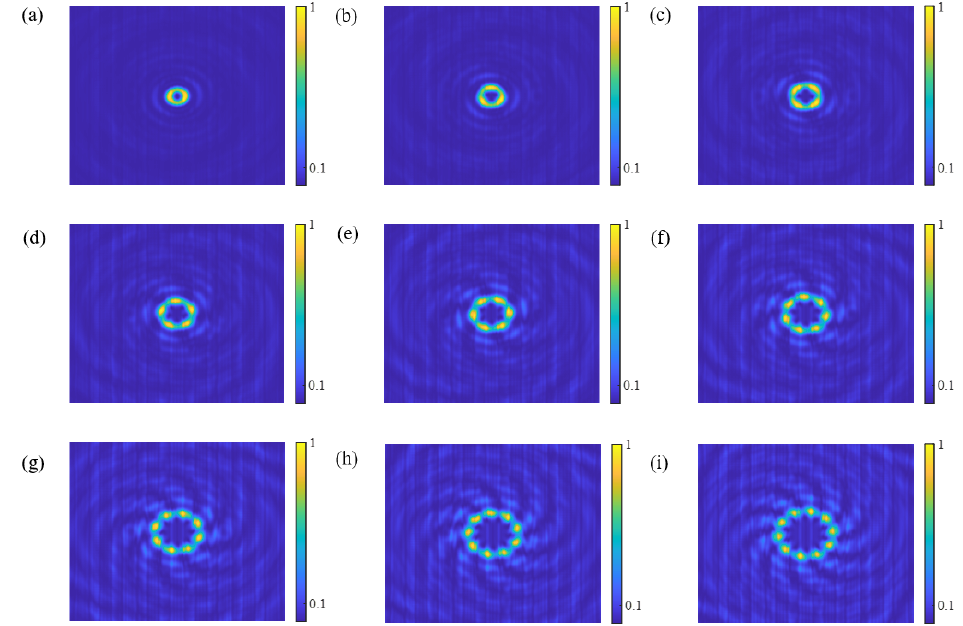
Figure 4. Simulated normalized diffraction patterns for the CSZPG with ( a ) l = 2, ( b ) l = 3, ( c ) l = 4, ( d ) l = 5, ( e ) l = 6, ( f ) l = 7, ( g ) l = 8, ( h ) l = 9 and ( i ) l = 10, respectively.